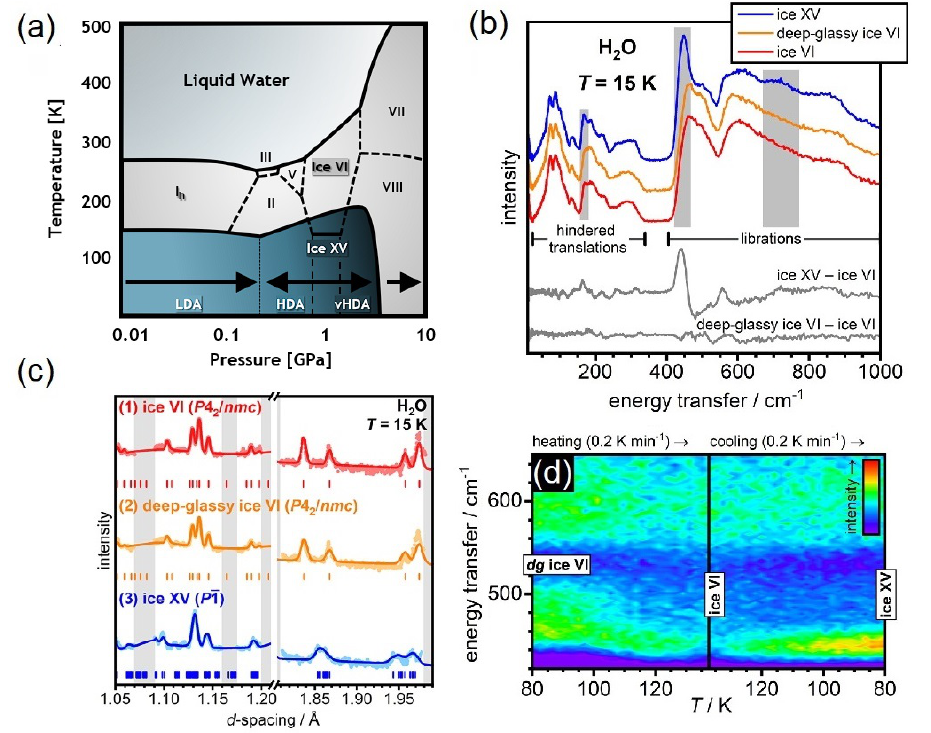
Figure 11. ( a ) Phase diagram of H 2 O in the range T = 4–300 K and p = 0.01–10 GPa, highlighting the thermodynamically stable forms of ice of relevance to our discussion (crystal phases VI and XV). Ice XV is the hydrogen-ordered counterpart of ice VI and is thermodynamically stable below 130 K over the pressure interval 0.8–1.5 GPa [321]. The phase diagram also includes the ranges of observation of metastable amorphous ices (Low-, High-, and very-High-Density Amorphous forms are denoted as LDA, HDA, and vHDA, respectively). The LDA phase is mostly found in the low-pressure region of the phase diagram (0–0.2 GPa), whereas HDA and VHDA occur at intermediate pressures (0.2–2 GPa). At high pressures ( > 2 GPa), only crystalline phases are stable [350]. ( b ) INS spectra of ice VI, deep-glassy ice VI, and ice XV, collected at T = 15 K on TOSCA+. The gray-shaded areas highlight the spectral range where major differences between ice VI and XV are observed. The spectra are shifted vertically for clarity. Difference spectra are shown in the lower part of the panel [328]. ( c ) ND patterns of (1) ice VI, (2) deep-glassy ice VI, and (3) ice XV collected simultaneously on TOSCA+ at T = 15 K. The experimental diffraction data are shown as light data points and the associated Rietveld fits as darker solid lines. Tick-marks indicate the expected positions of Bragg reflections. [328]. ( d ) Contour plot of the librational region upon heating deep-glassy ice VI from 80 to 138 K, followed by cooling back to 80 K [328]. Adapted with permission from Ref. [328,350]. Copyright (2021) American Chemical